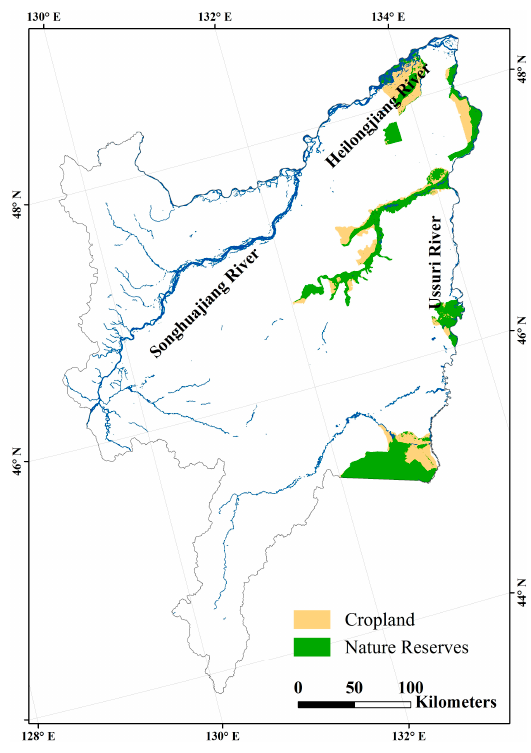
Figure 6. Cropland distribution in Wetland National Nature Reserves in the Sanjiang Plain.